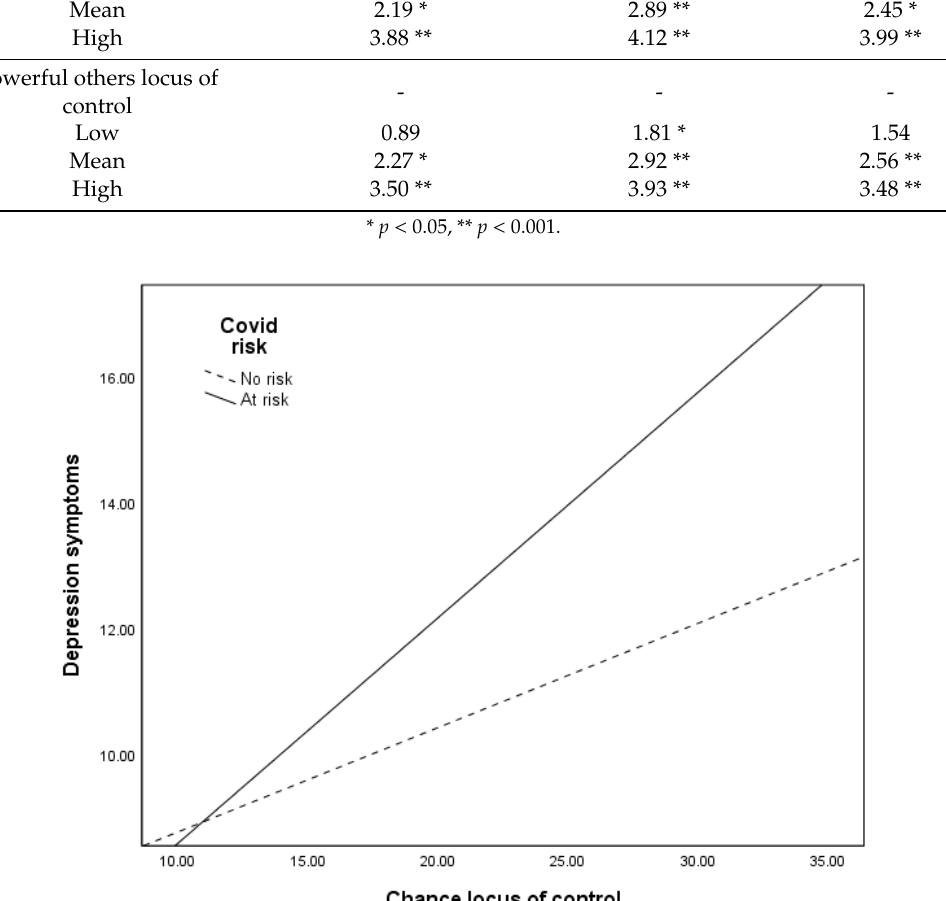
Figure 1. The relationship between chance locus of control and depression symptoms. Table 4. The relationship between risk of COVID-19 at different levels of external locus of control.